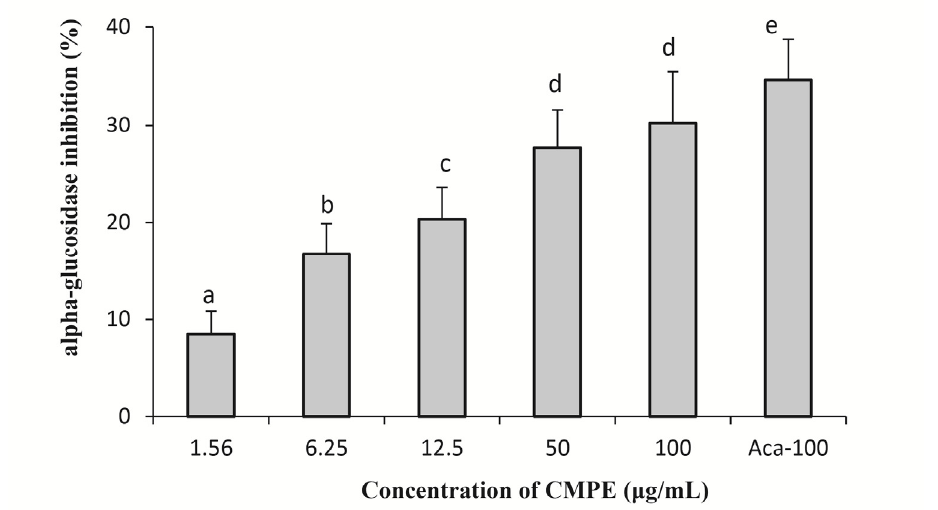
Figure 6. Dose-dependent inhibition of CMPE on rat α -glucosidase. Acarbose (100 μ g/mL) is used as positive control and denoted as Aca-100. Bars marked by different letters are significantly different ( n = 5, p < 0.05).